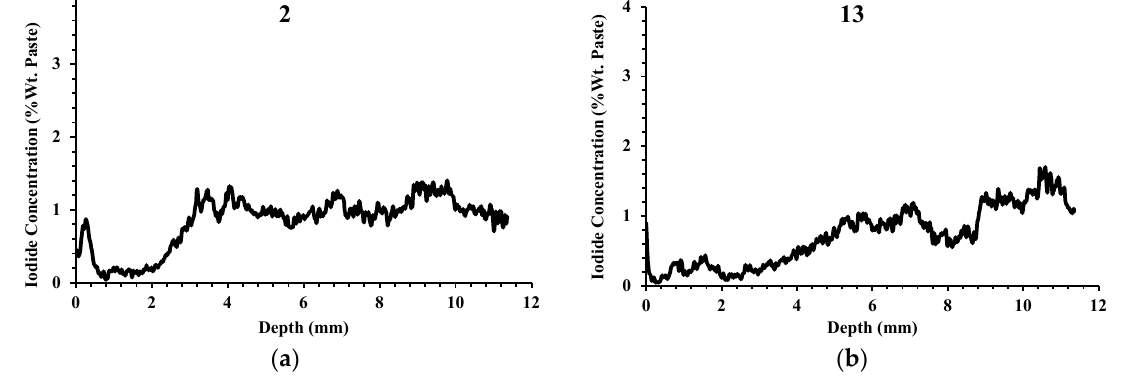
Figure 8. Examples of two cracked samples ( a ) concentration profiles in sample 2; ( b ) concentration profiles in sample 13.